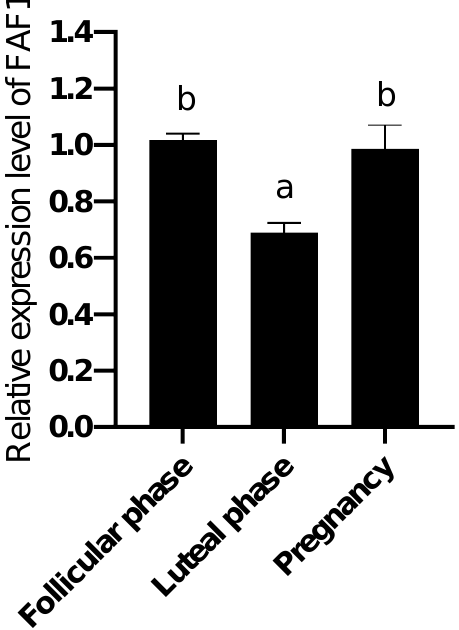
Figure 7. Relative expression levels of FAF1 protein in ovaries of different reproductive cycles (different letters indicate significantly different values at p < 0.05).